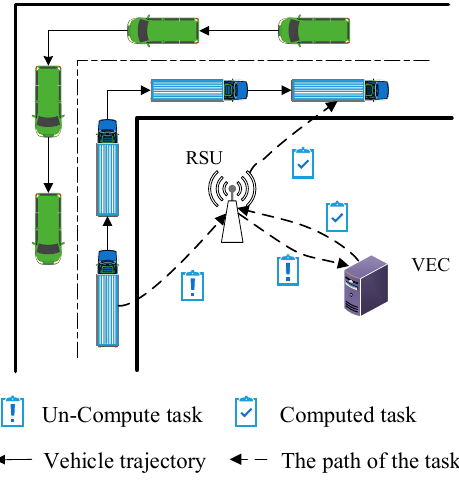
Figure 2. Illustration of Vehicular Edge Computing (VEC) network application scenario.